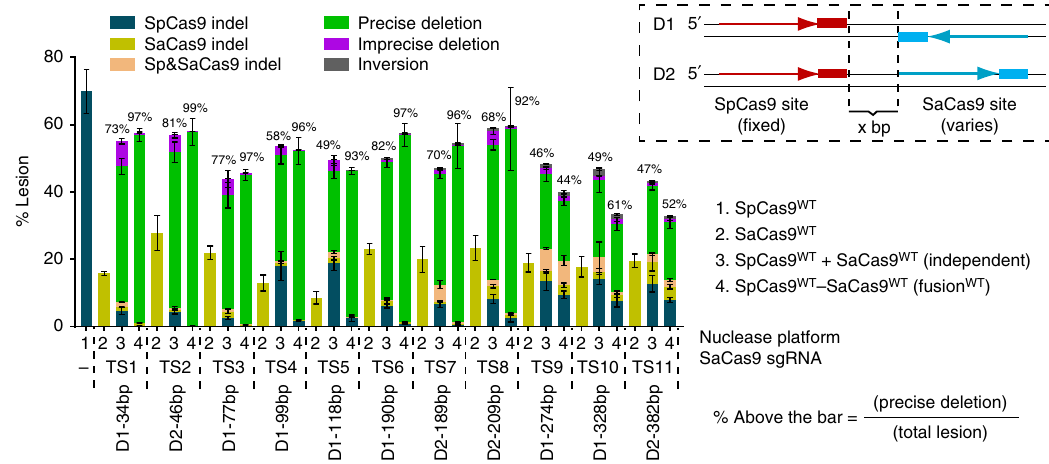
Fig. 4 Cas9 – Cas9 dual nucleases display enhanced precise deletions out to ~200 bp site separation. Changes in the activity pro fi le of SpCas9 WT – SaCas9 WT nuclease as a function of the distance between sgRNA-binding sites at the AAVS1 locus. Boxed inset: schematic of the orientation of the target sites, where the SpCas9 site is fi xed and the SaCas9 site is shifted to examine the distance-dependent activity of the Cas9 – Cas9 fusions (Supplementary Fig. 2). Bar graph: deep sequencing data, where the various lesion types and rates at AAVS1 sites are determined by UMI-corrected deep sequencing. Data are from three independent biological replicates performed on different days in HEK293T cells, where the orientation and spacing between the orthogonal Cas9 sites is indicated below the x -axis (Supplementary Data 1). Error bars indicate ±